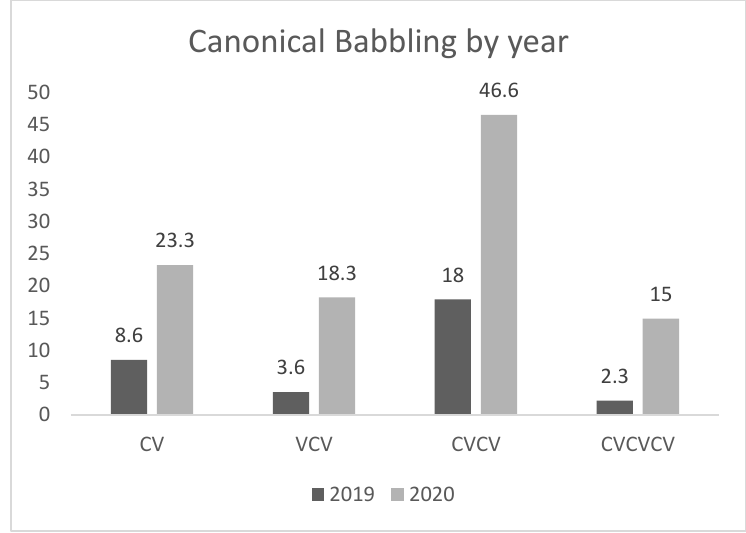
Figure 1. Mean volubility of the last three months of each intervention. Post hoc analyses of the data revealed a significant difference between the mean number of disyllable vocalizations of approach B (AO approach) in comparison with ap- proach A (traditional speech therapy) ( p = 0.05). Post hoc analyses did not reveal any other significant difference, despite the observed graphic improvement of the mean number of vocalizations per type between the two habilitation approaches. As shown in Table 2, one-way repeated-measure ANOVAs were conducted within and between subjects to assess whether there were statistical differences in the primary outcome measure with regard to baseline (approach A) and therapy AO (approach B). The mean number of vocalizations was calculated for each protophone type. Specifically, var- iable ‘phase’ was significantly related to the vocalization outcome (F = 9.4, df = 1, p = 0.035). Table 2. Effect of AO (approach B) on volubility versus traditional speech-language therapy (ap- proach A). Repeated measures ANOVA. Within Subjects’ Effects Sum of Squares